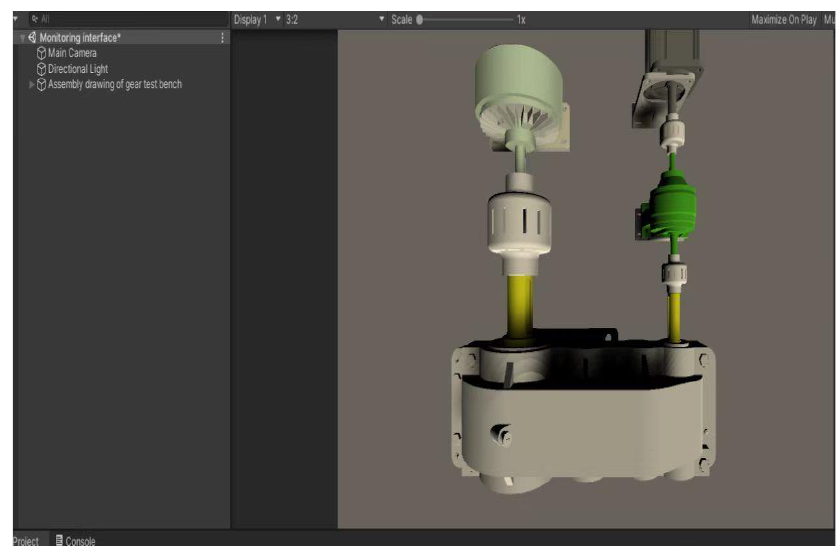
Figure 7. Digital twin interface of the gear test bench.